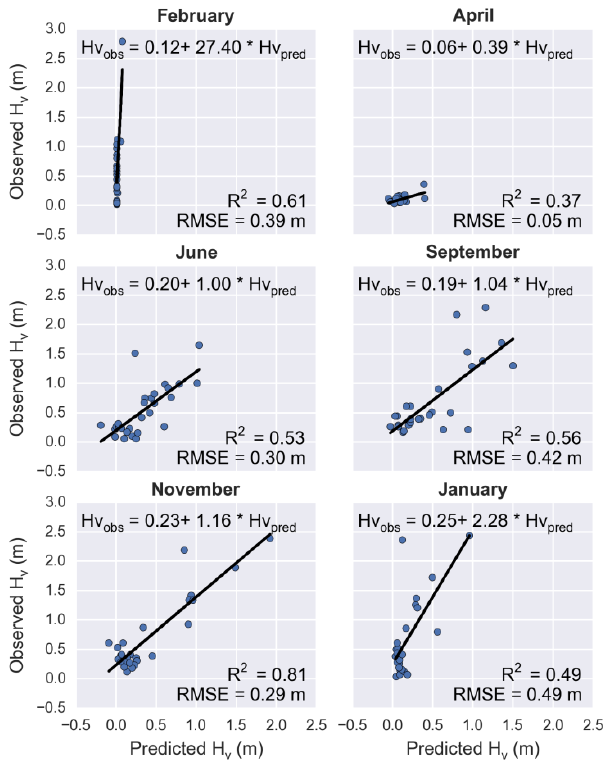
Figure 3. Linear regression of predicted H for each